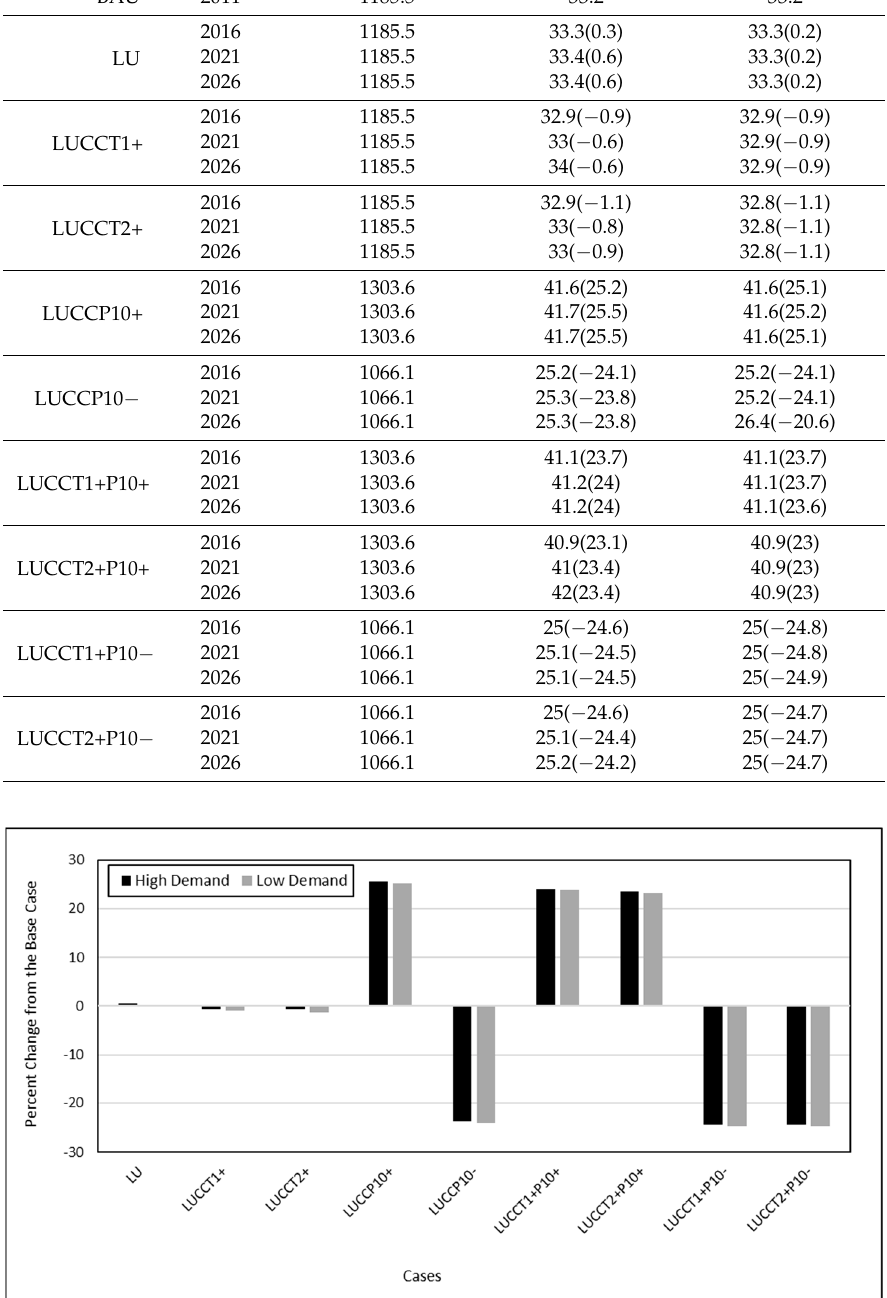
Figure 9. Changes in streamflow (%) with High and Low Demand scenarios for industrial wood pellets.